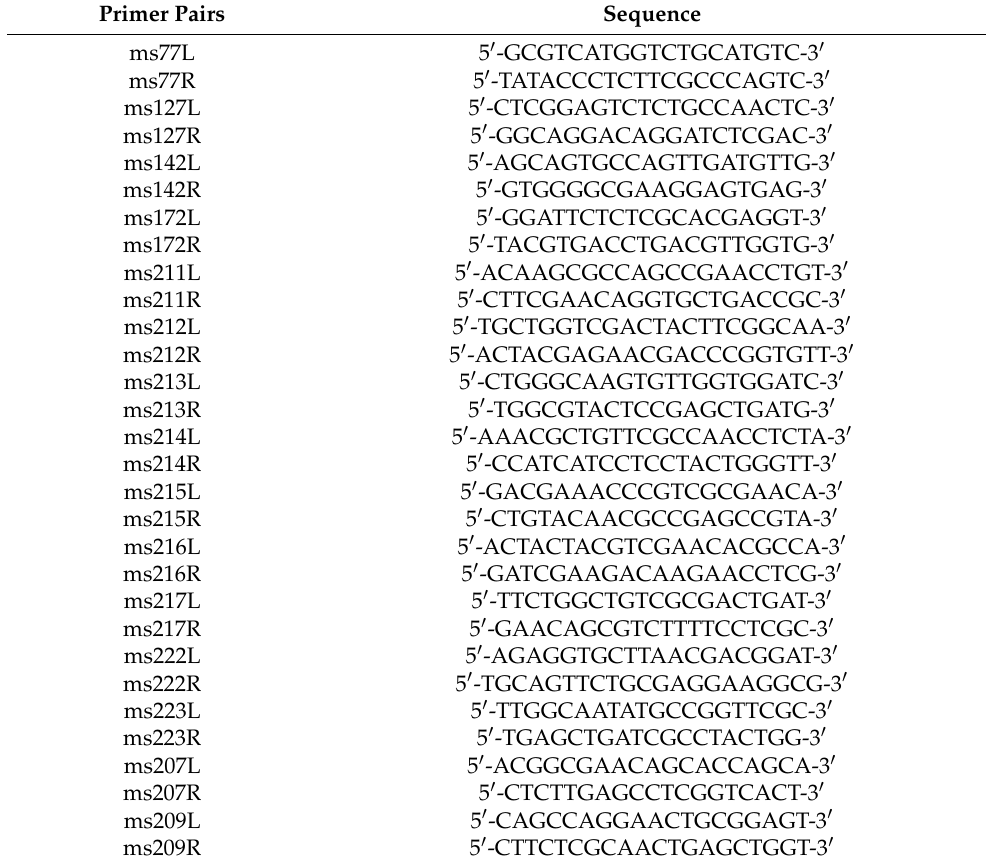
Table 1. Primer pairs used for